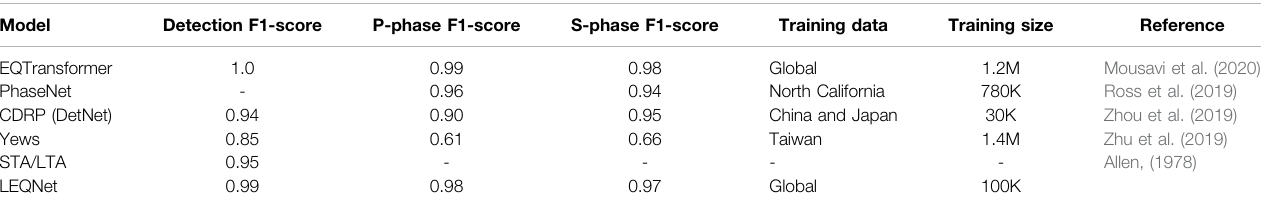
TABLE 3 | Model result of detection and P-phase and S-phase